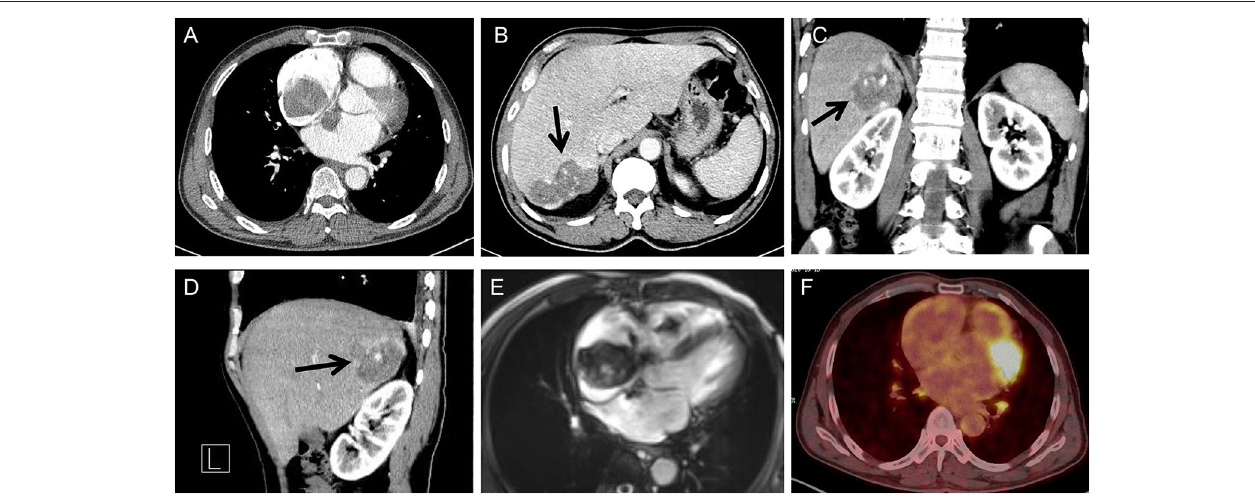
FIGURE 2 | Cardiac CT showing a biatrial mass with the atrial septum infiltrated (A) ; Abdominal CT showing an angiomatous mass in the right posterior lobe of the liver (arrow) (transverse view) (B) , coronal (C) , and sagittal (D) plane; cardiac MRI showing a giant biatrial mass with tricuspid valve involved (E) ; PET-CT showing a giant mass with increased glucose metabolism in the right atrium (F) .